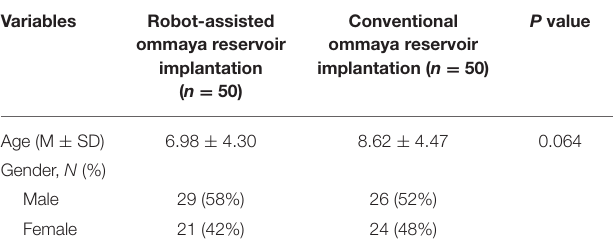
TABLE 1 | Patient